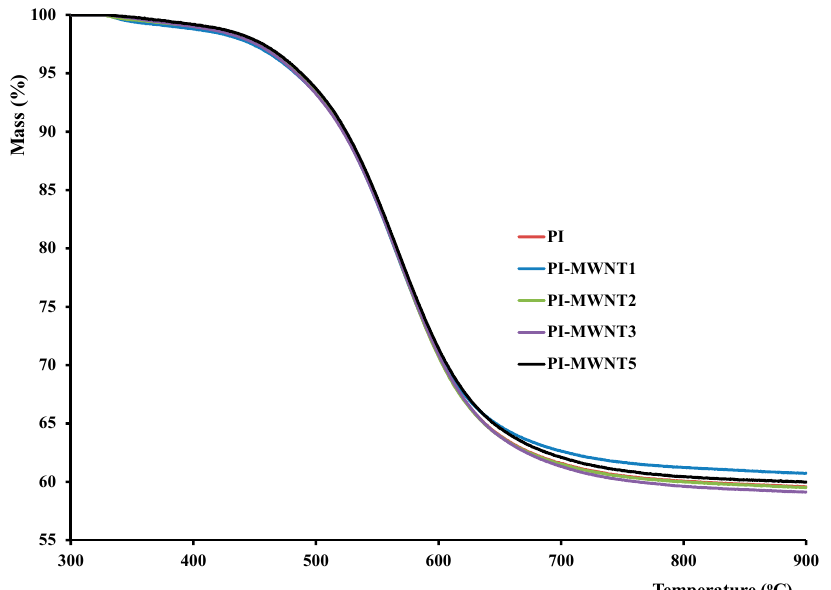
Figure 5. TGA curve for a pure polyimides (PI) membrane and PI-MWCNTs membranes. Table 2. Loss of membrane mass during pyrolysis at the maximum temperature and glass transition temperature of the polymer.